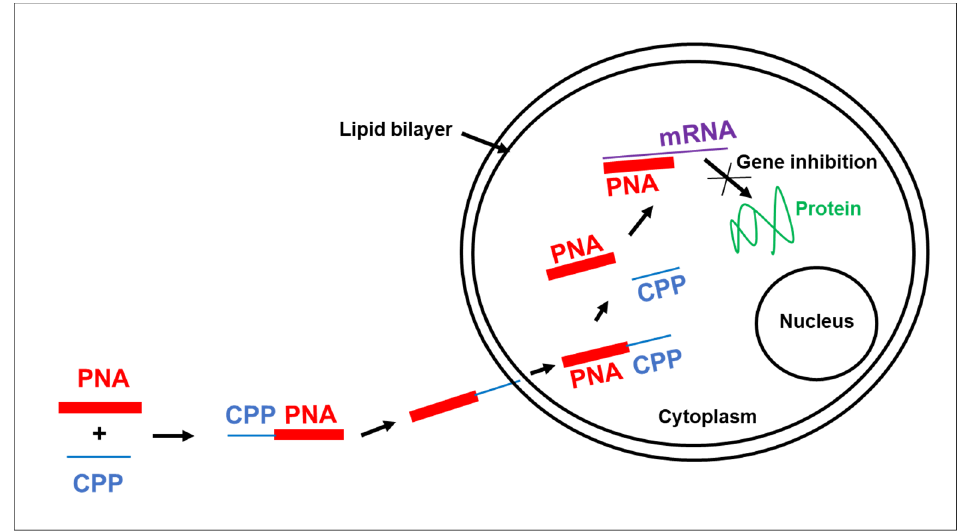
Figure 1. The coupling of Peptide Nucleic Acid (PNA) to cell penetrating peptides (CPP), a nonviral gene delivery system, improves their intracellular uptake and induces gene inhibition.